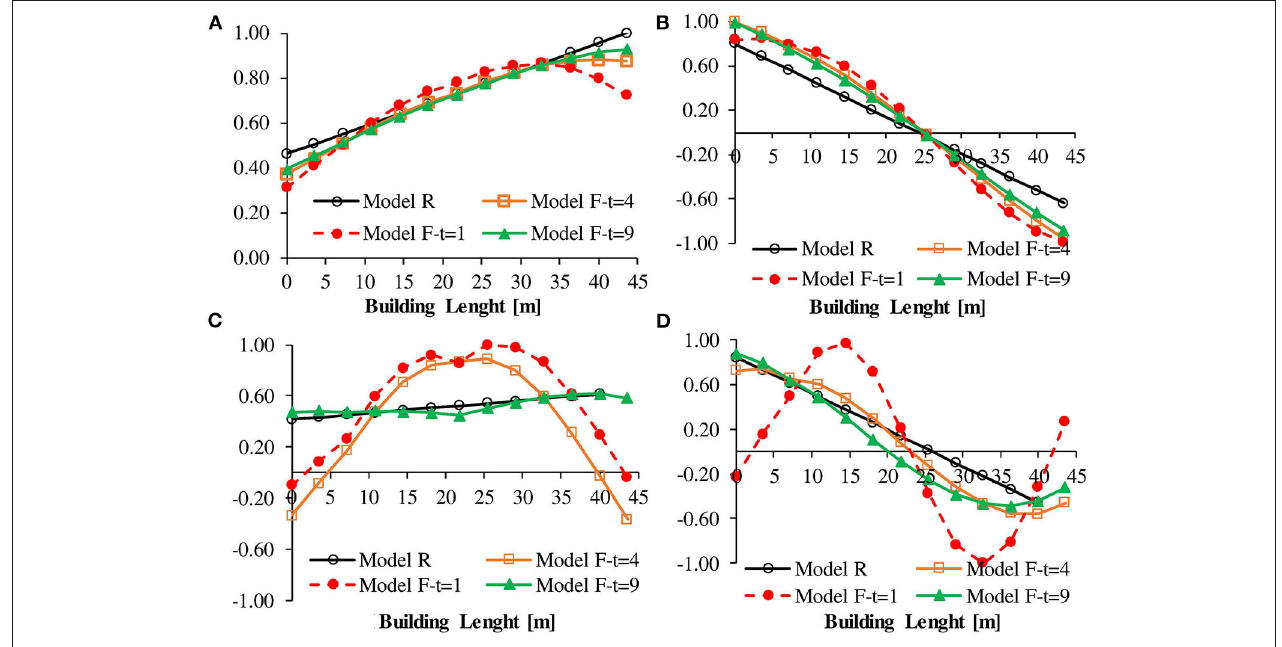
FIGURE 7 | Mode shapes for the roof diaphragm (infilled frame): (A) first translational Y; (B) first torsional; (C) second translational Y; (D) second torsional.